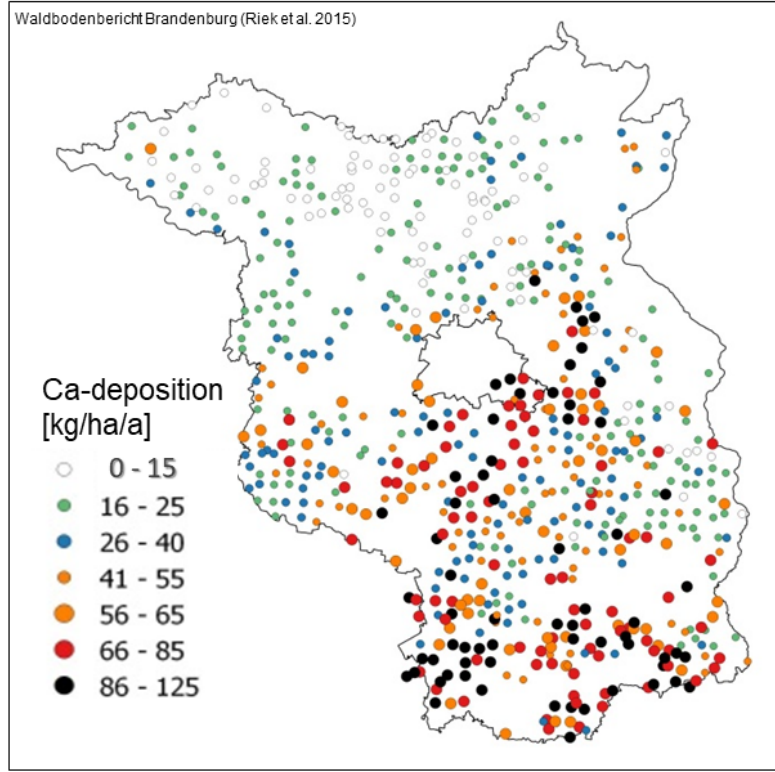
Figure 9. Calculated throughfall inputs of calcium for 1988 on the basis of pine bark samples on the grid of the forest condition survey of the former GDR (from: Riek et al. [38]).